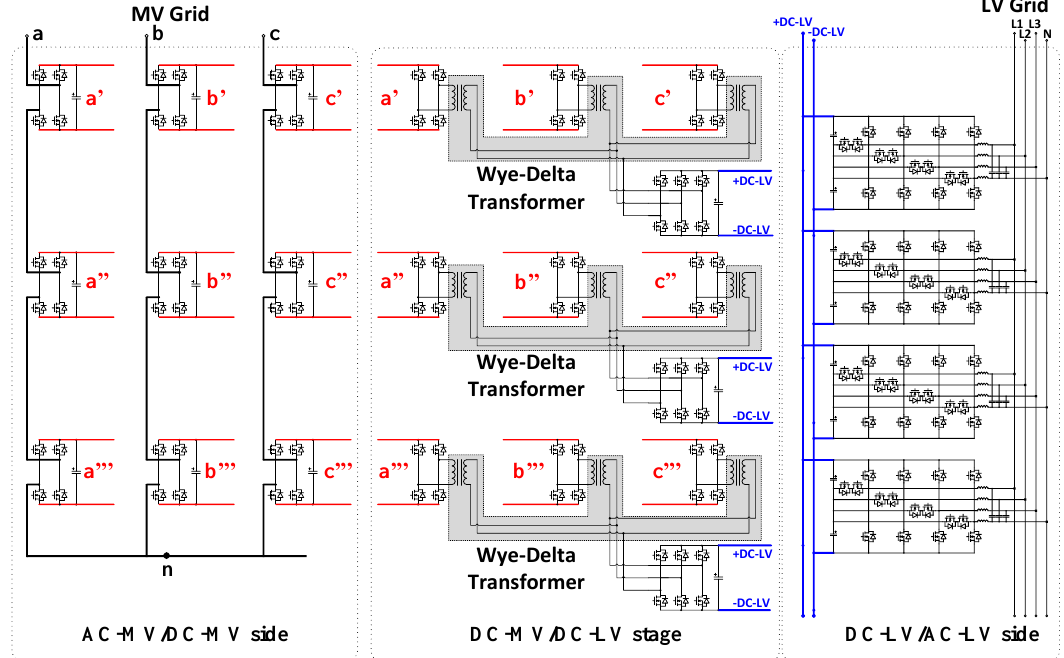
Figure 2. The full model of the considered Smart Transformer (ST) with wye-delta high-frequency (HF) transformers and LV DC link as a point of common coupling for DC systems‐model separated for different power stages.